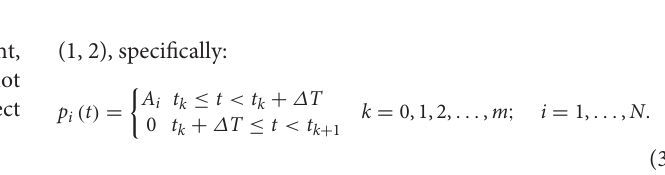
FIGURE 5 | Comparison of solution diagrams of four coupled cells in cyclic array, σ M = 100s − 1 , k ADP = 0.10 s − 1 , with varied ratio of q : (A) q = 1.2, (B) q = 100. Red curve—asymmetric non-uniform stationary state; blue curve—homogeneous stationary state; green curve—symmetric non-uniform stationary state; full line—stable stationary solution, dashed curve—unstable stationary solution; empty square—Hopf bifurcation point; empty diamond—symmetry breaking bifurcation point. Each stable stationary state has assigned a symbolic representation of its